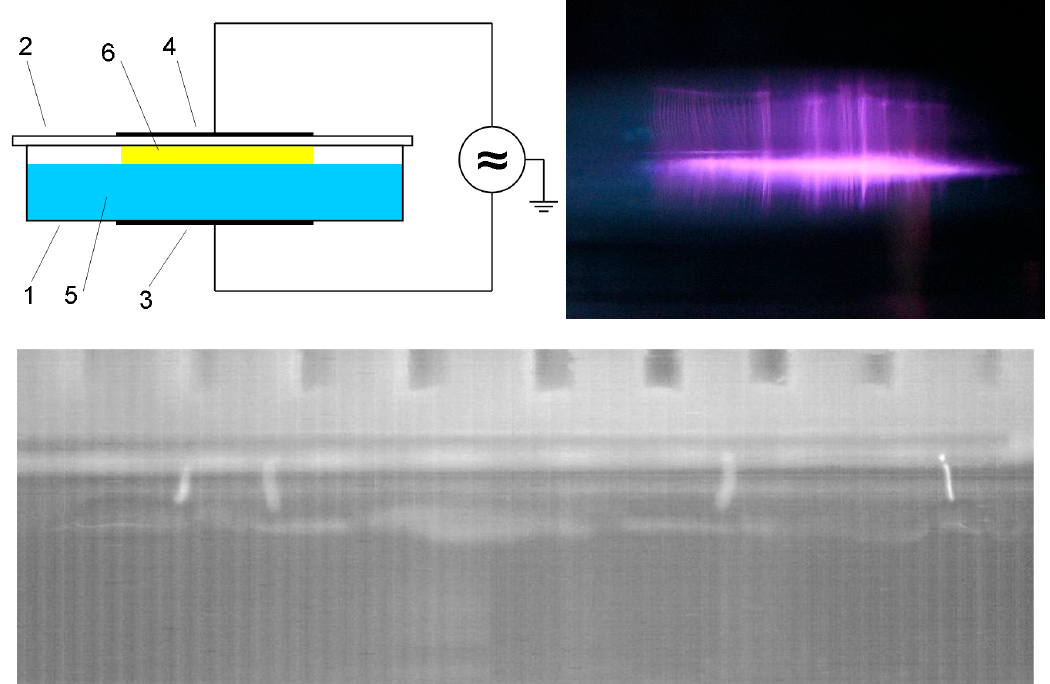
Figure 1. Upper left: Scheme of the PAW production experimental setup. 1—Pyrex glass Petri dish; 2—alumina plate; 3—graphite lacquered electrode; 4—silver electrode; 5—treated water; 6—plasma zone. Upper right: Photo of plasma during the discharge operation in the reactor. Bottom: Discharge channels visualized by the fast camera (movie, see Supplementary Materials. Acquisition rate was 1000 frames per second, projection rate was 2 frames per second).